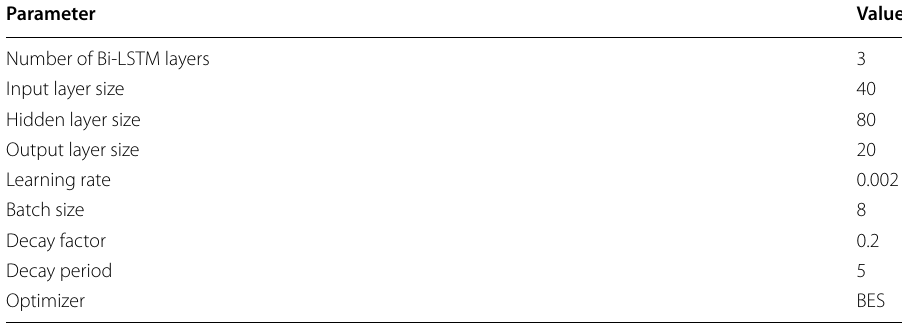
Table 2 Parameter setting of proposed model Parameter Value Number of Bi-LSTM layers 3 Input layer size 40 Hidden layer size 80 Output layer size 20 Learning rate 0.002 Batch size 8 Decay factor 0.2 Decay period 5 Optimizer